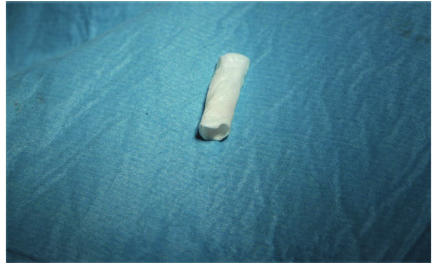
Figure 1: Tubular PHEA-PLA-PCL